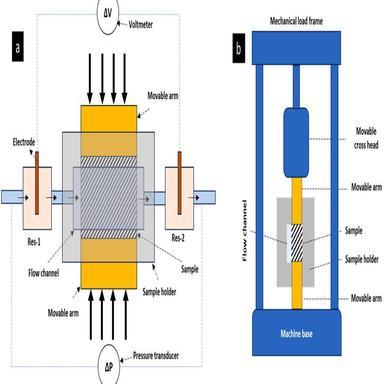
Schematics of the setup. a) Top view of the sample holder and the adjacent reservoirs. b) Side view of the load frame and the sample holder.